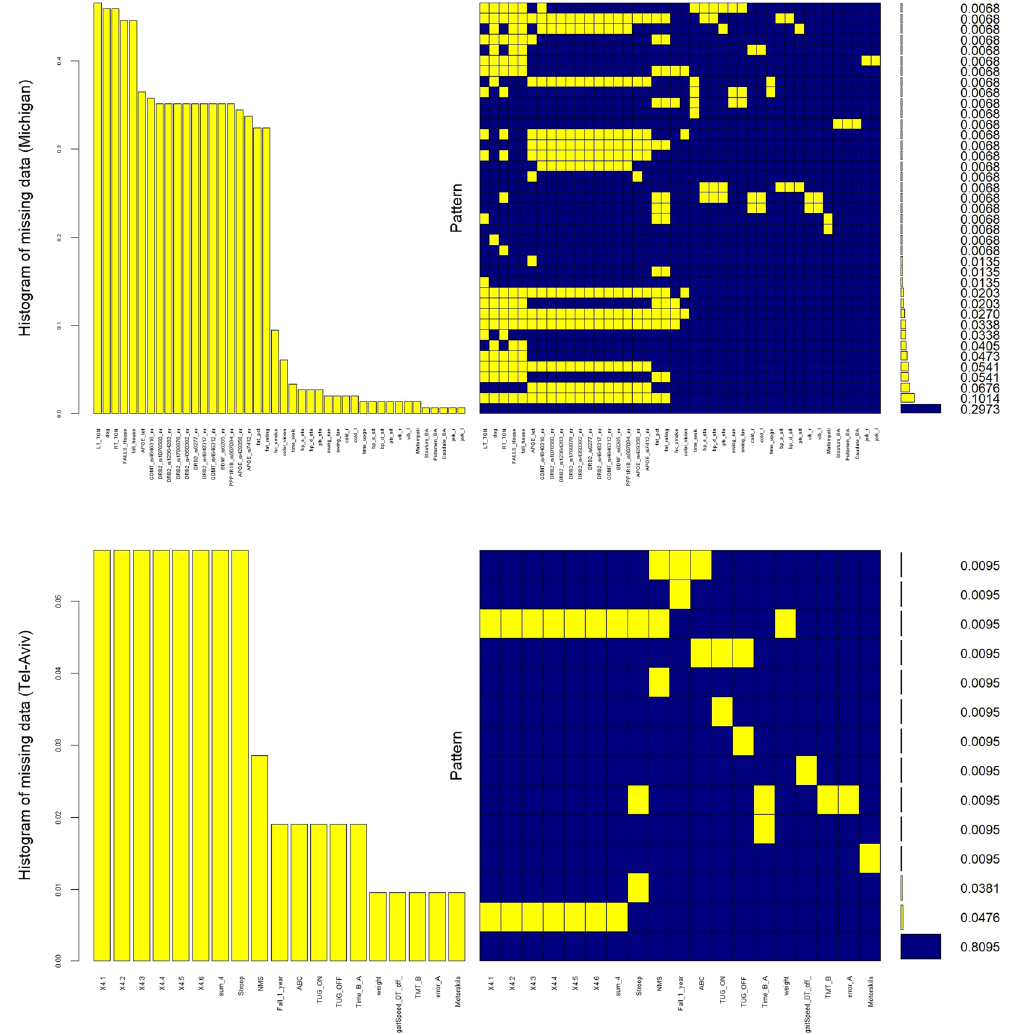
Figure 4. Missing patterns of Michigan (top) and Tel-Aviv (bottom) datasets. Approximately 30% of the Michigan study subjects have complete information, e.g., many cases have unrecorded genetic biomarkers. Data completeness is higher in Tel-Aviv data, missingness only occurred in about 19% of the participants.